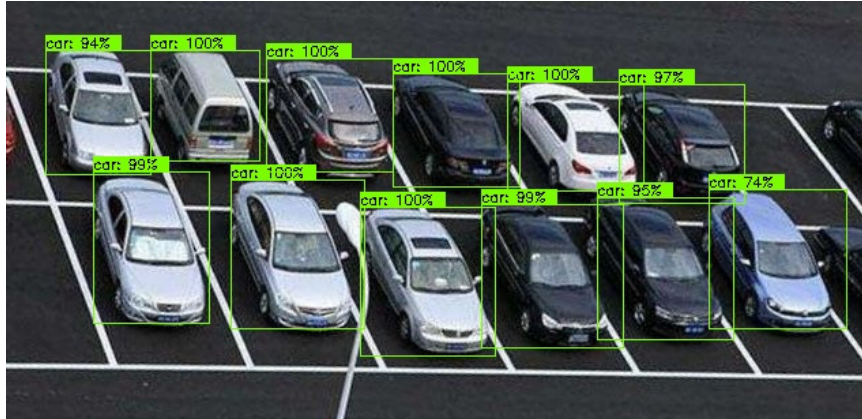
Figure 15. Identification of vehicles under the condition of full parking.